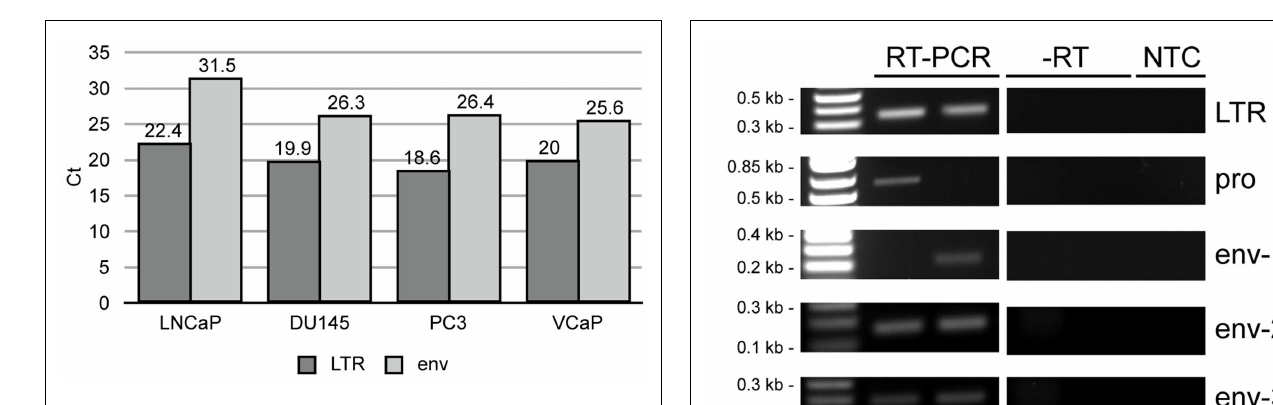
FIGURE 5 | Quantitative RT-PCR of HERV-K LTR and env sequences in prostate cancer cell lines .Threshold cycle is shown for the viral components in each cell line.